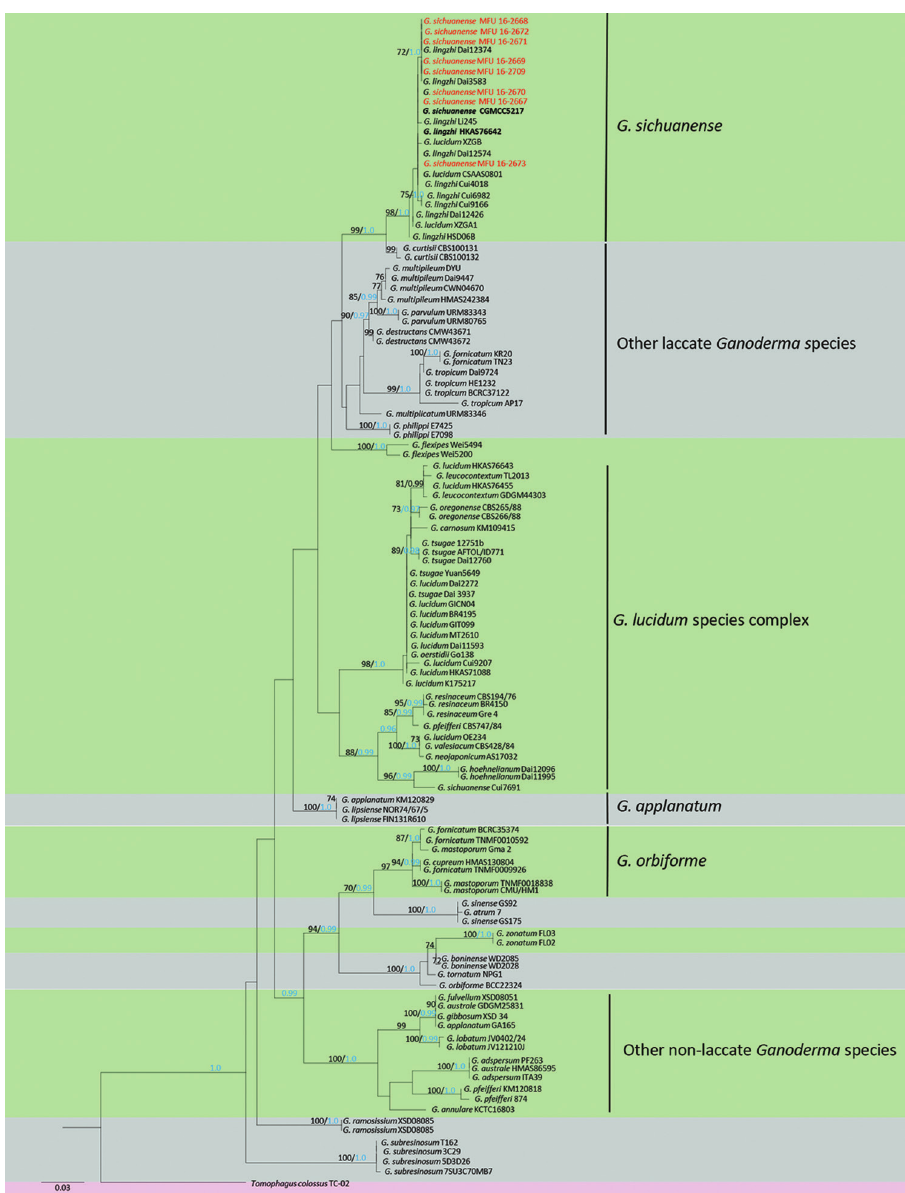
Figure 1. Phylogram generated by maximum likelihood analysis of 5.8S-ITS rDNA sequences. Boot- strap support values for maximum likelihood (in black) greater than 70% and Posterior Probabilities (PP) from Bayesian Inference (in blue) ≥0.95 are given above branches. The tree was rooted with Tomophagus colossus . The strain numbers are mentioned after the species names. Specimens of the newly recorded spe- cies are indicated in red and type specimens are indicated in black bold. (Treebase ID